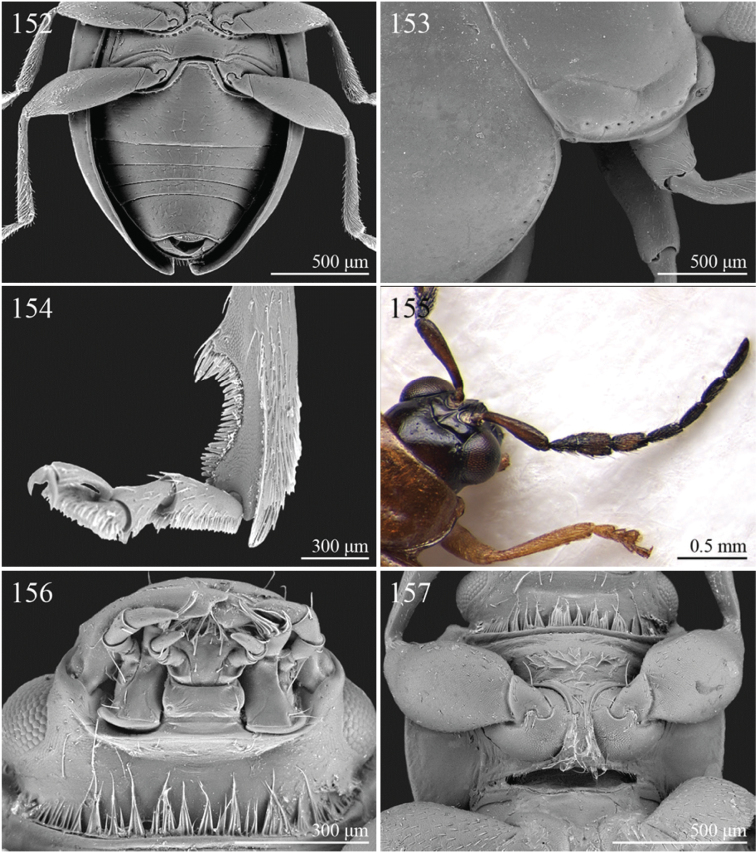
Morphological characters. 152
Celisaltica ruwenzorica Biondi, metasternum and abdomen 153
Chabria betsimisaraka Biondi & D’Alessandro, sublateral sulci on pronotum 154
Chaetocnema sudafricana Biondi & D’Alessandro, ciliate dentate emargination of hind tibiae 155
Chaillucola formicicornis Bechyné, head and right antenna in dorsal view in male 156
Chirodica similfulva Biondi, buccal parts 157
Chirodica chalcoptera Germar, prosternum and anterior femora in ventral view.